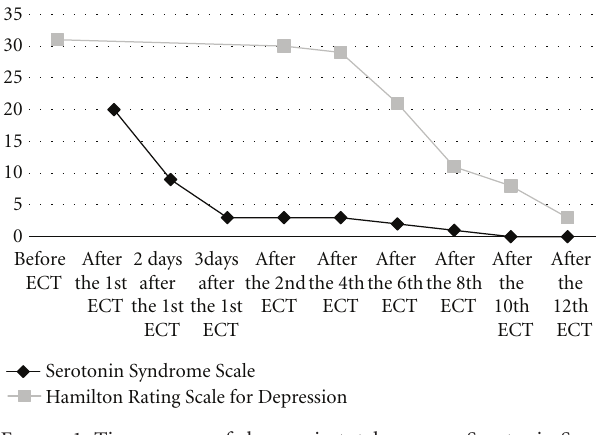
Figure 1: Time-course of changes in total score on Serotonin Syn- drome Scale and Hamilton Rating Scale for